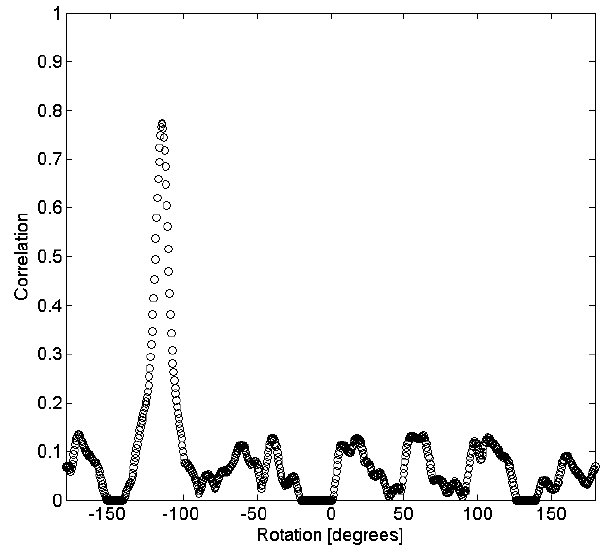
Figure 7. The correlation for different rotation angles used to match TLS detected trees with manually measured tree positions for one example field